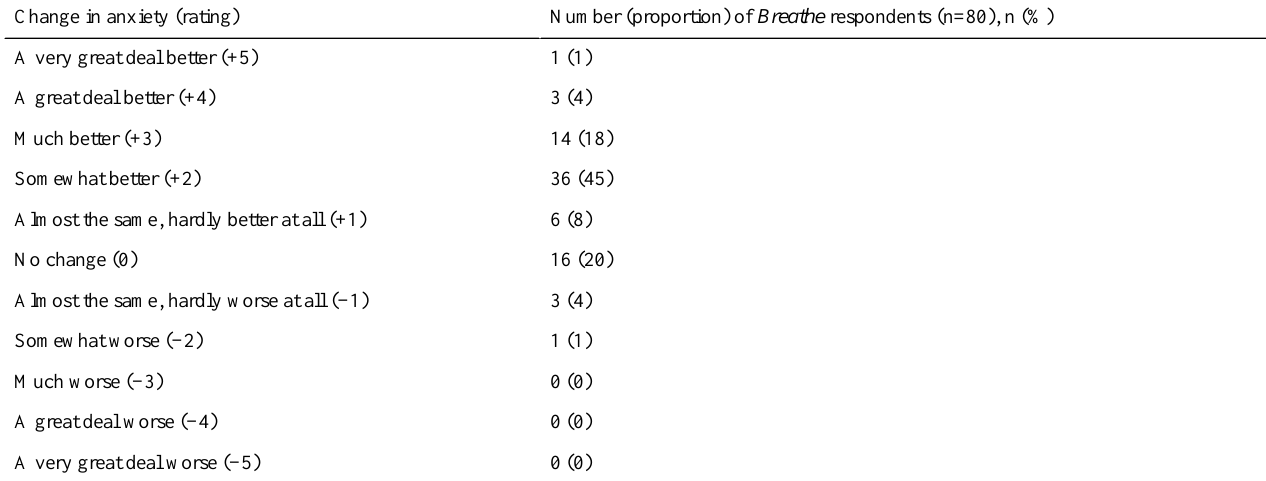
Table 12. The change in anxiety levels as reported by Breathe respondents using the Global Rating of Change